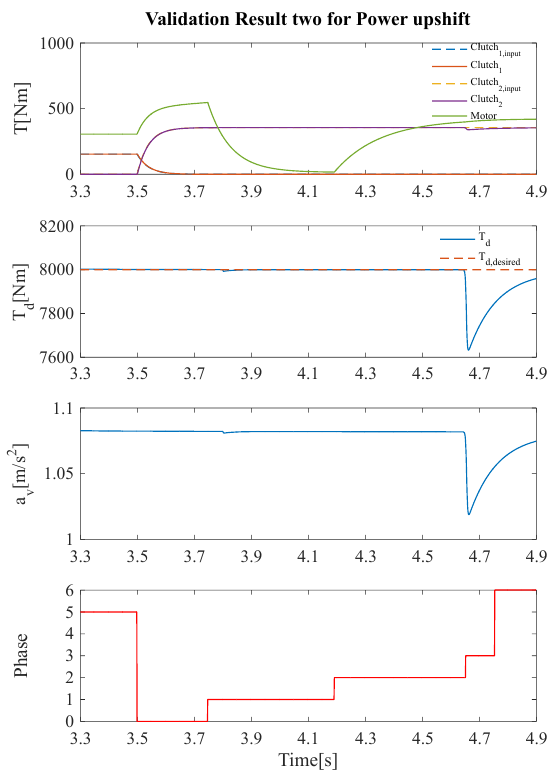
Figure 10. Control variables during the upshifting